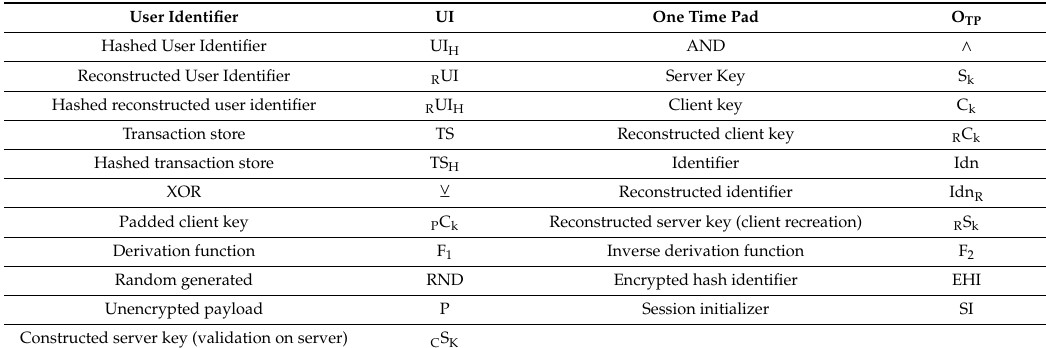
Figure 4. Initialization at the beginning of a session. Table 1.